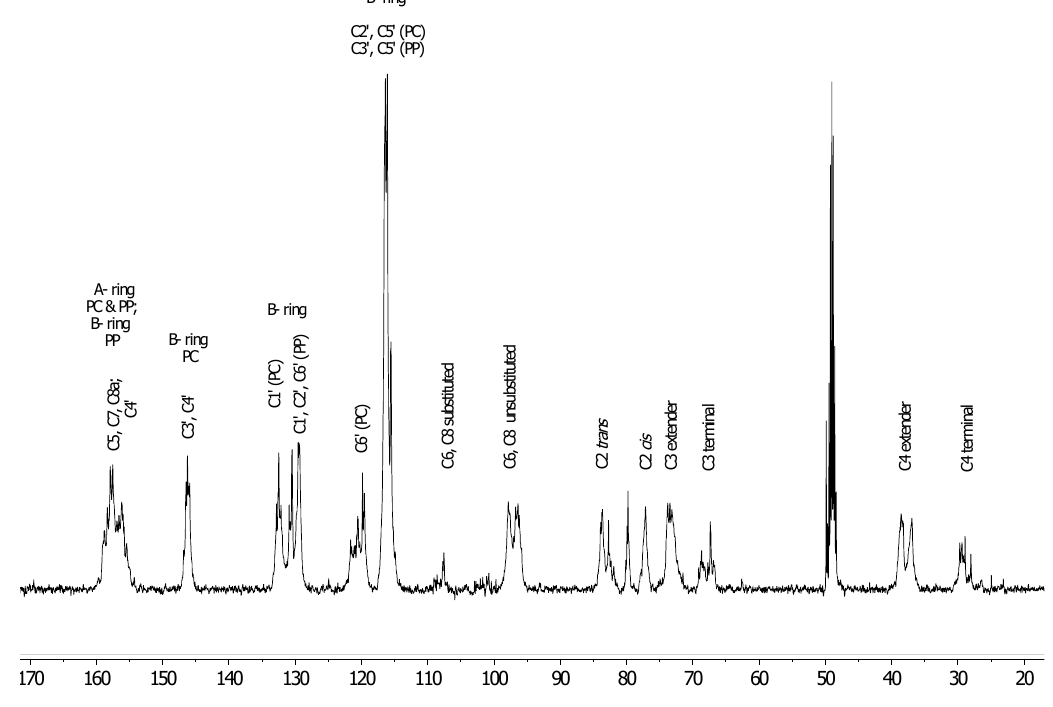
Figure 2. 13 C-NMR (MeOD) for a polyphenolic fraction of leaves (LH-F3) from U. tomentosa.